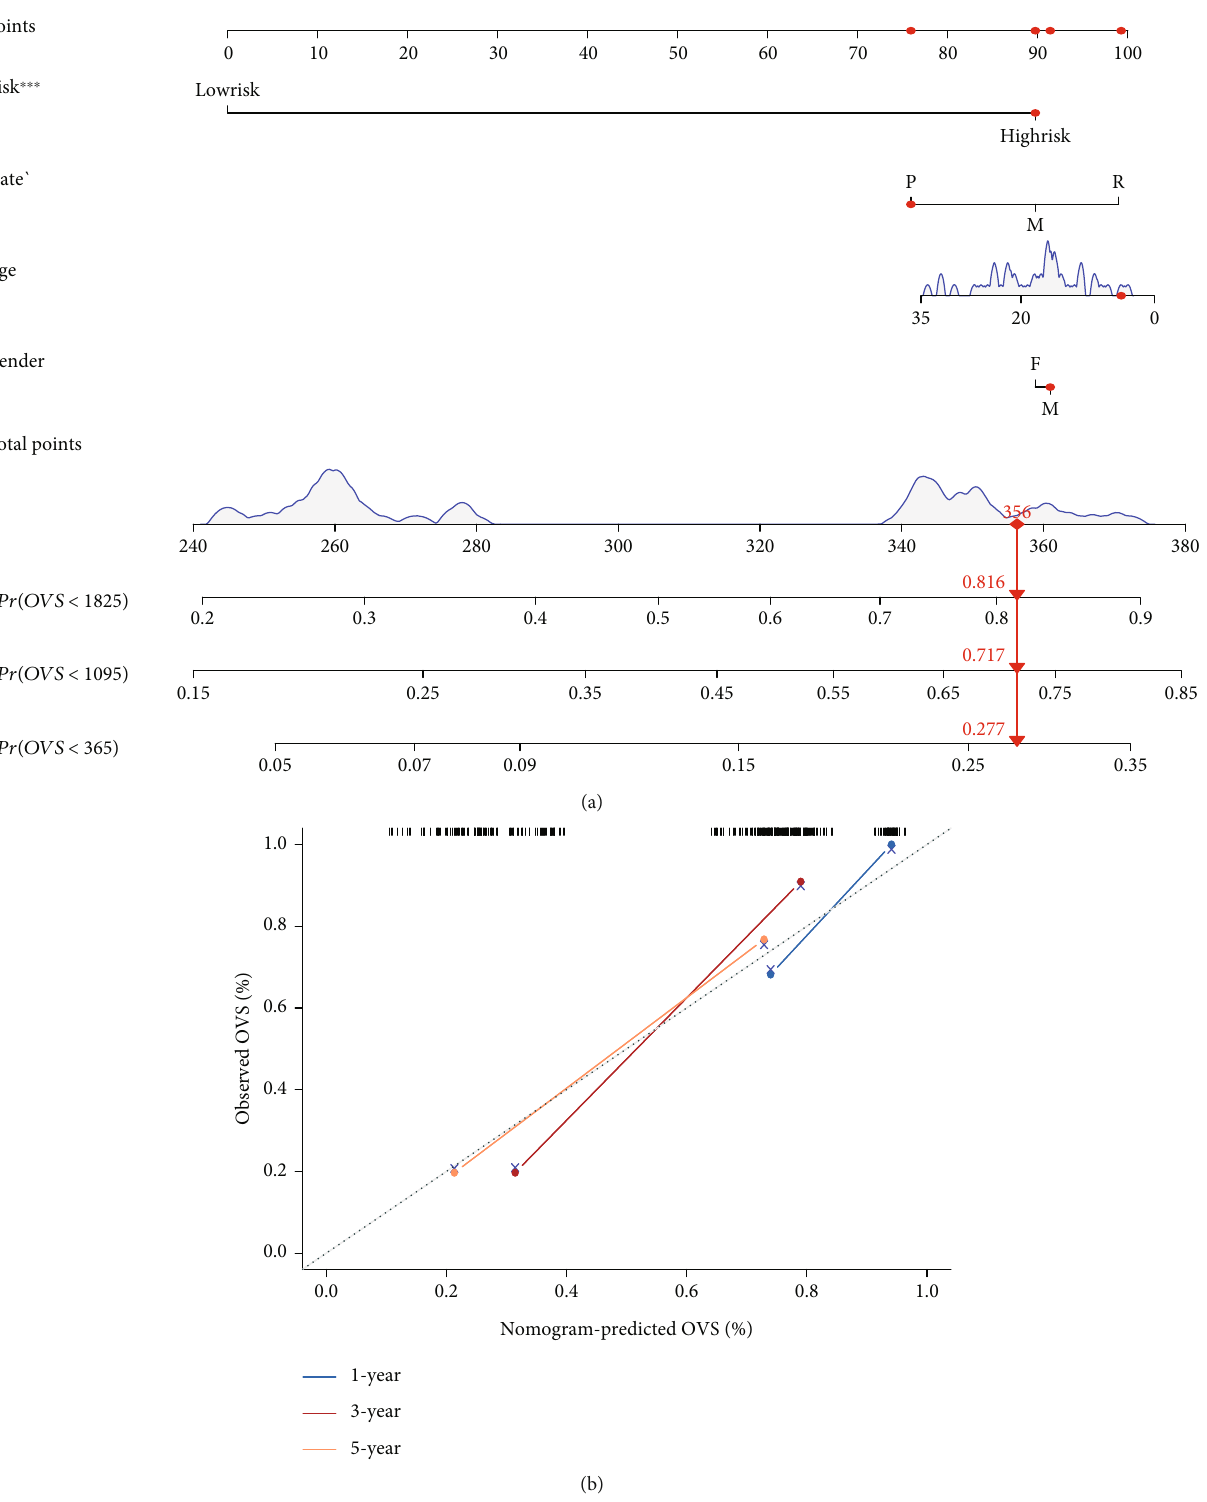
Figure 9: Nomogram plot and calibration curves. (a) Nomogram for predicting the 1-, 3-, and 5-year survival probability of patients with ES (state: P: primary; R: recurrence; M: metastasis). (b) Calibration curves for the nomogram at 1, 3, and 5 years (OVS: overall vital survival). The Y axis represents the actual OVS while the X axis represents the predicted